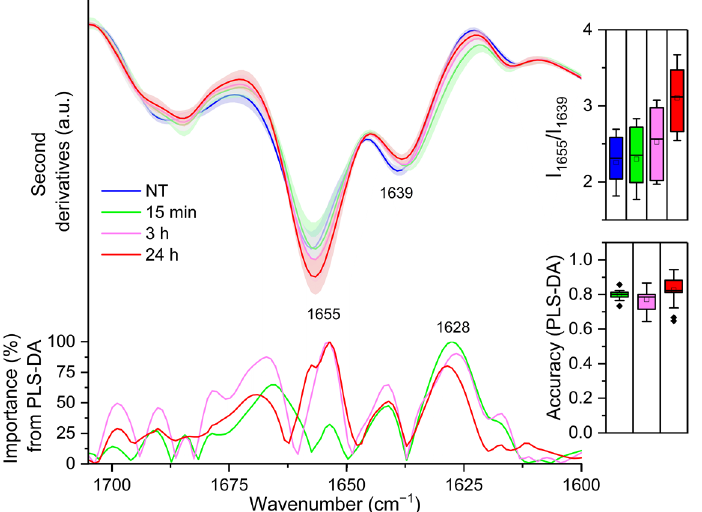
Figure 2. Mean second derivative spectra in the Amide I band of THP-1 cells before (0 h) and at different time points of LPS treatment. Standard deviation has also been displayed as a shadowed area. In the inset, the intensity ratio between the 1655 cm − 1 and the 1639 cm − 1 peaks, taken from the second derivatives, is illustrated. Below, the wavenumber importance for PLS-DA discrimination performed in the 1700–1600 cm − 1 spectral range is shown. The PLS-DA discrimination accuracy has been also reported. Box plots are given as in Figure 1.